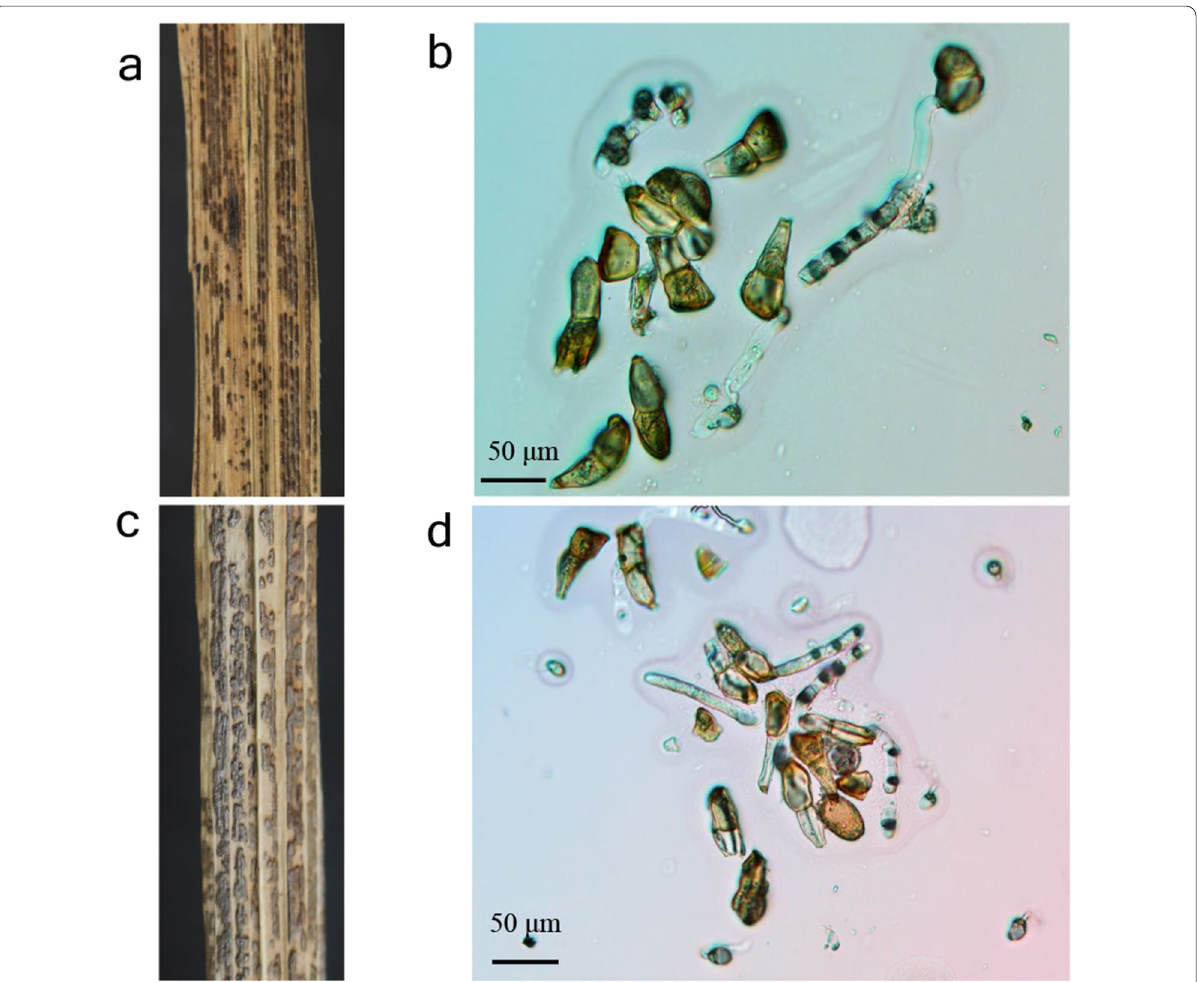
Fig. 3 Microscopic observations of germination of teliospores directly after sampling from leaves of two grass species. The grass plants with uredia were labelled in the autumn, 2013 and collected after overwintering in March, 2014. Observations of teliospore germination were performed with a light microscope. a Telial sori on A. cristatum . b Germination of teliospores from A. cristatum . c Telial sori on E. cylindricus . d Germination of teliospores from E. cylindricus . There was no significant difference in teliospore germination of telial samples between A. cristatum and E. cylindricus at the level of 0.05 ( P =